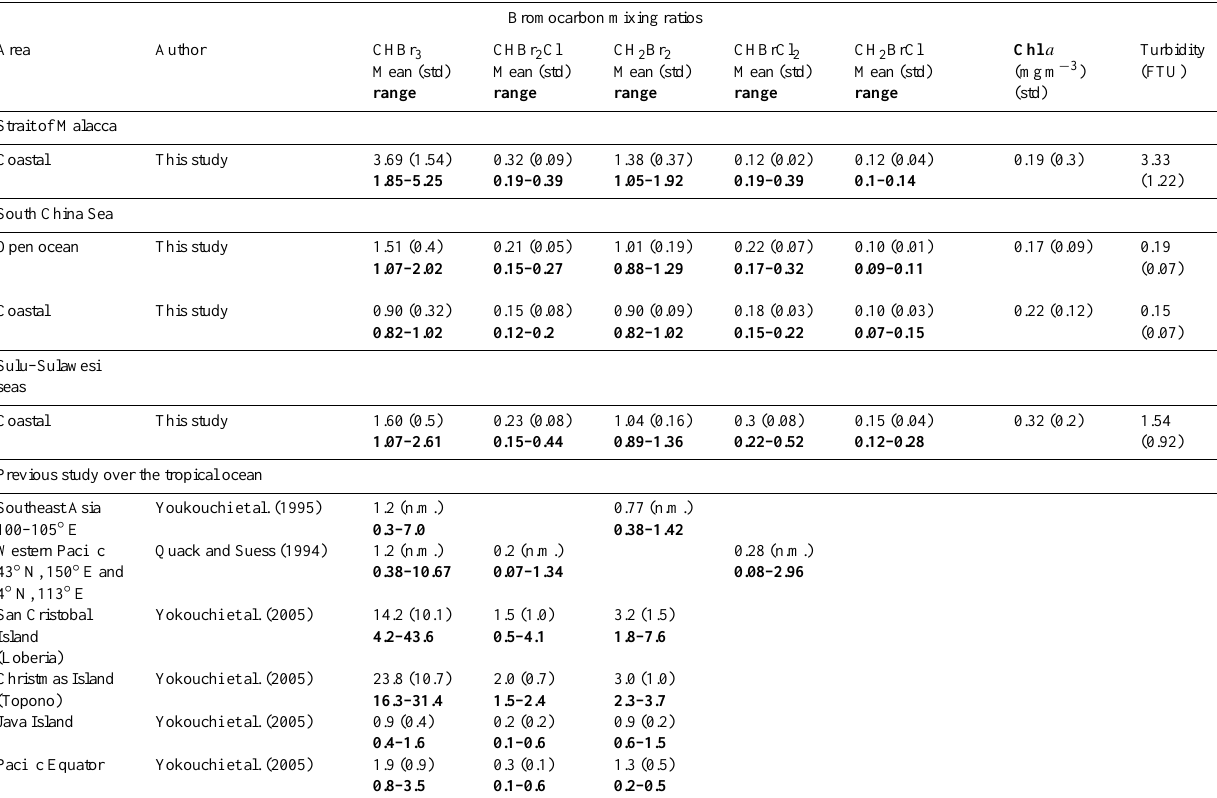
Table 1. Mean, standard deviation (in brackets) and range (in bold) values of the measured halocarbon concentrations in this work and values from the literature based on tropical ocean areas (n.m.: not